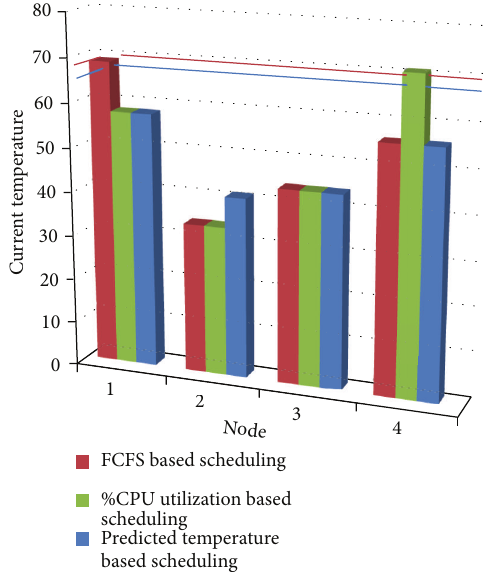
Figure 4: Comparison of FCFS, %CPU utilization, and predicted temperature based scheduling for Scenario 1.